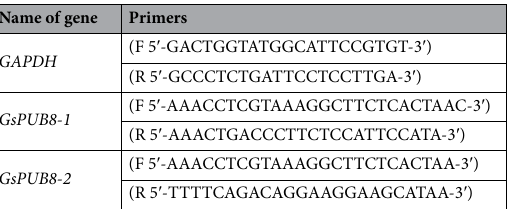
Table 1. List of primers designed for cloning of GsPUB8 gene and qRT-PCR